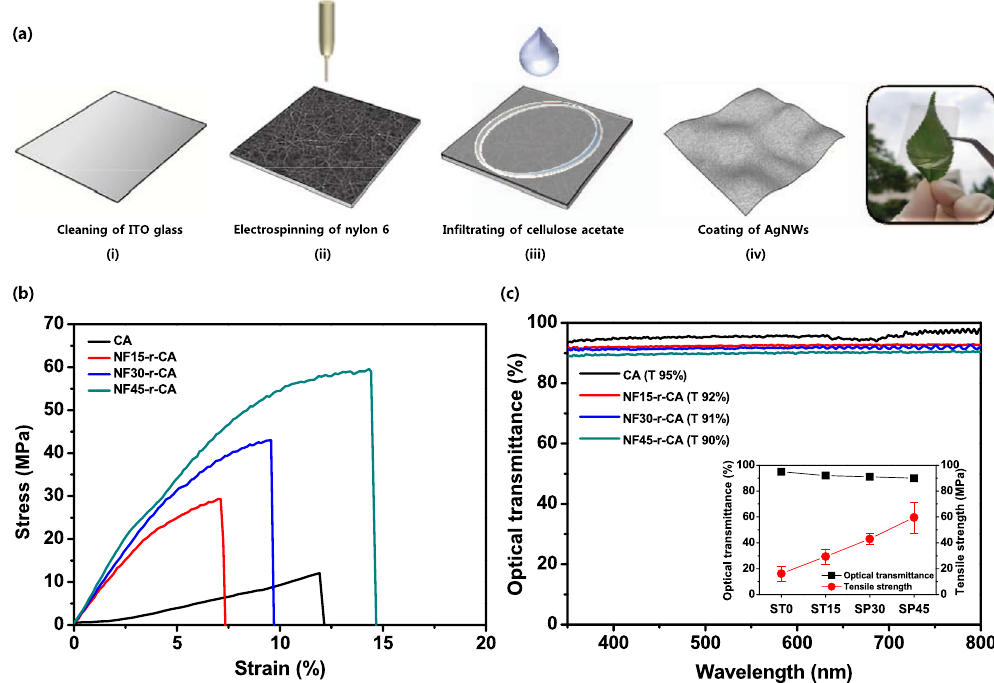
Figure 1. Schematic illustration of the fabrication procedure for the highly transparent fiber-based electrodes. ( a ) Fabrication process steps for the highly transparent fiber-based electrodes with excellent durable and foldable properties. Stress-strain curves ( b ) and optical transmittance ( c ) of bare CA film and NF-r-CA films (NF15-r-CA, NF30-r-CA and NF45-r-CA films) with different nanofiber contents at room temperature. The right inset shows the relationship between the optical transmittance and the tensile strength of the NF-r-CA films with different nanofiber